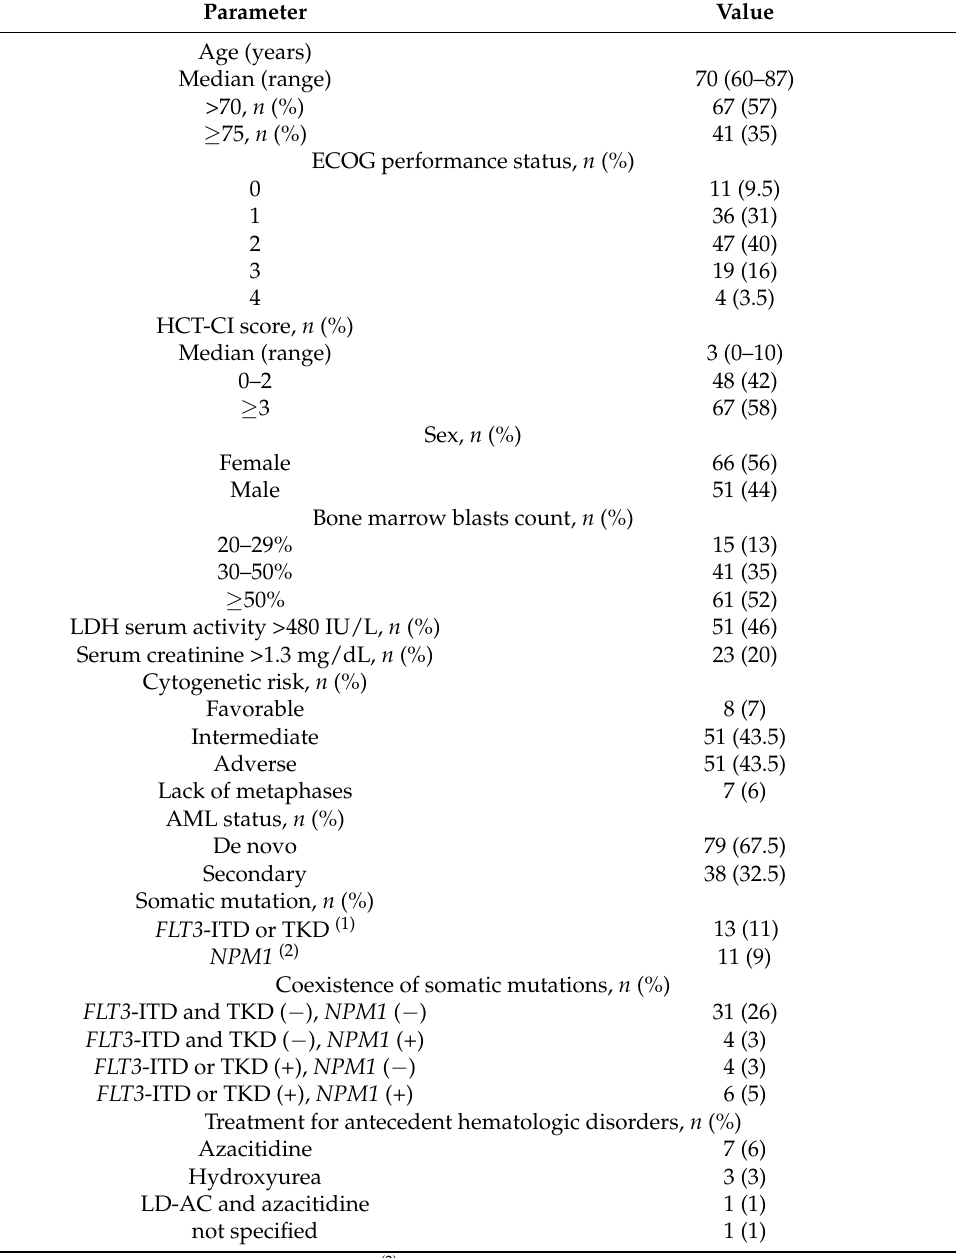
Table 1. Patient and disease baseline characteristics ( n =